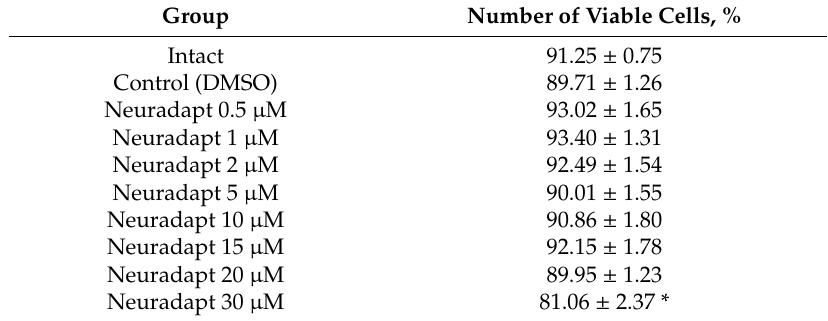
Table 1. Neuradapt toxicity for primary hippocampal cultures assayed on day 7 post-treatment.